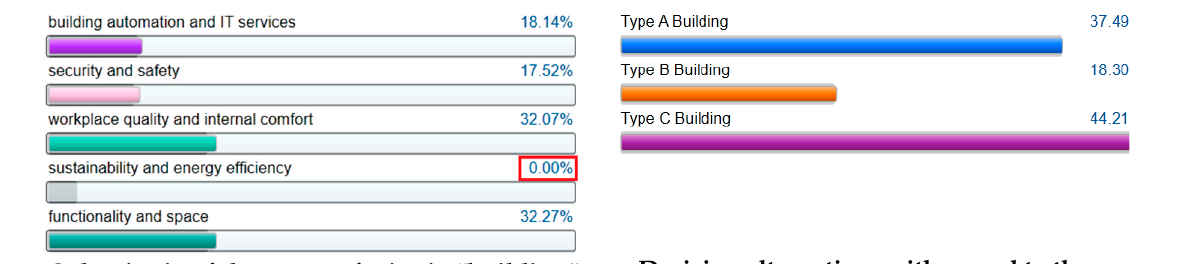
Figure 7. Relevance ranking (%) of sub-criteria of the group of criteria “building” with regard to the choice of adequate office space for BPO tenants with “sustainability and energy efficiency” ranked at 0%.